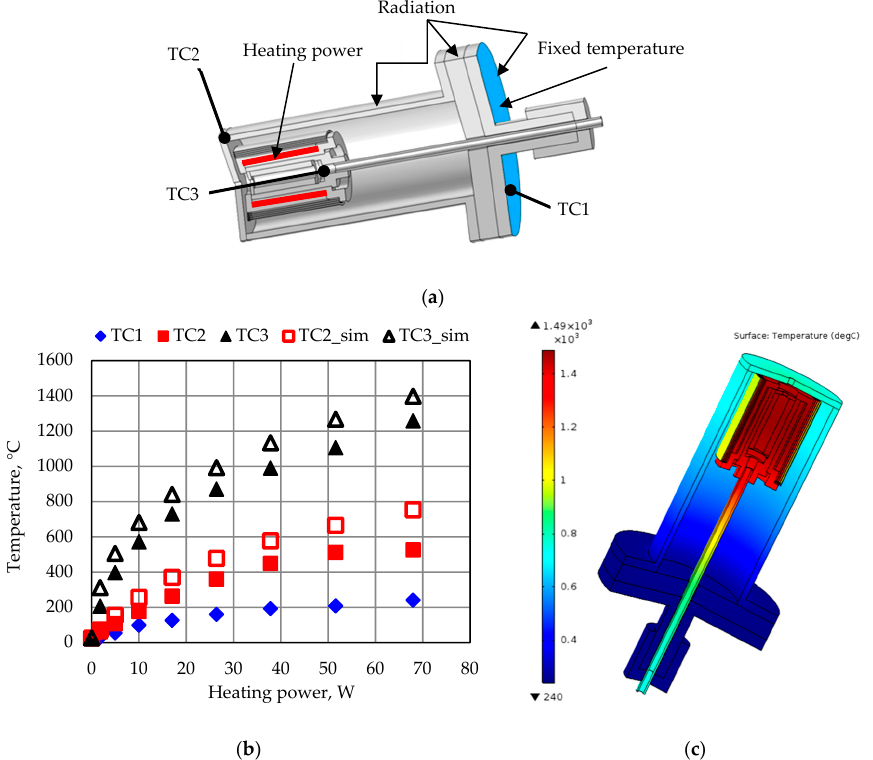
Figure 11. Temperature measurements and simulations results for the PSAC cathode: ( a ) cathode schematic showing the locations of the thermocouples and the boundary conditions for the 2D axysimetric thermal simulations; ( b ) temperature variation with heating power; ( c ) steady-state thermal simulation result for a heating power of 68 W and a fixed temperature set to 240 °C.